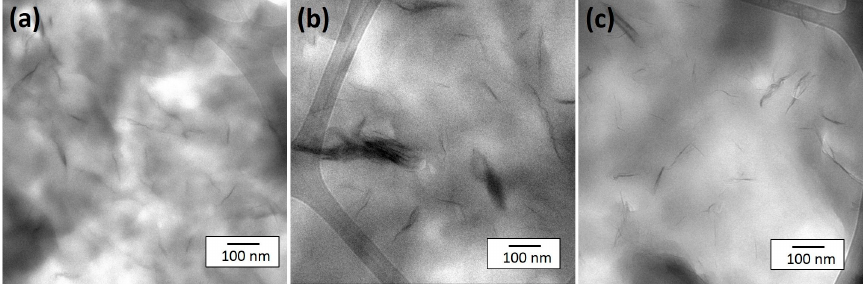
Figure 6. Representative transmission electron microscope images of: ( a ) PA6/organoclay; ( b )